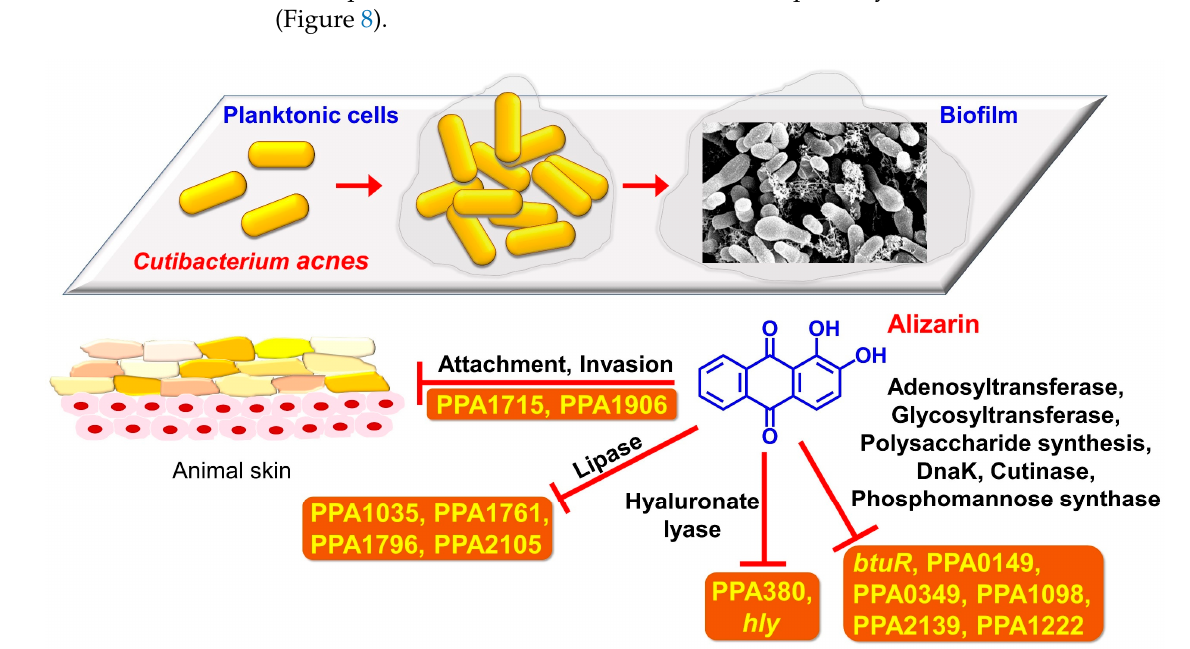
Figure 8. Diagram of the putative mechanism of alizarin in C. acnes .